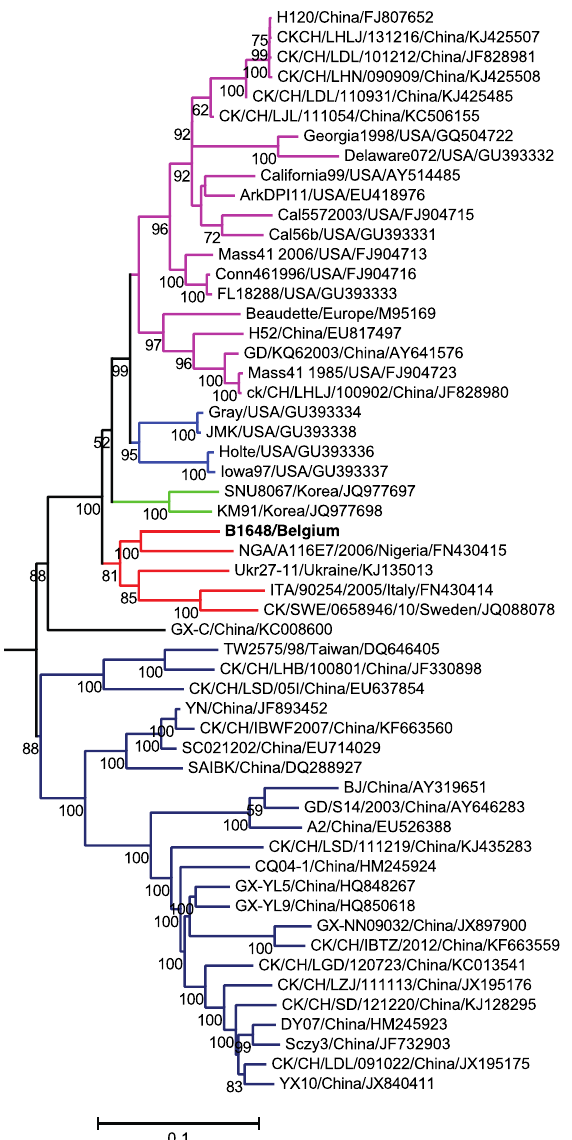
Figure 1. Maximum likelihood phylogenetic tree based on 55 full genome sequences. Bootstrap values ( n = 500 replicates) of <50% are not shown. Strain B1648 cluster is shown in red.